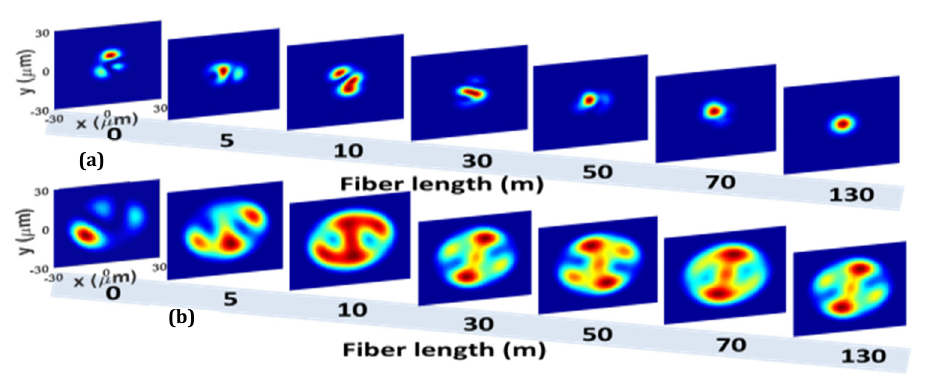
Figure 6. ( a , b ) Spatial beam evolution in the GRIN-F and the STEP-F, respectively, where the initial energy is equally distributed among all the modes.